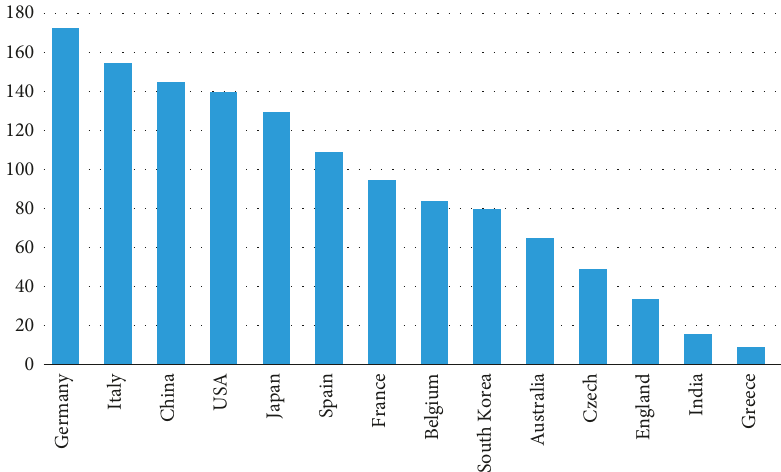
Figure 4: The number of patents registered in each